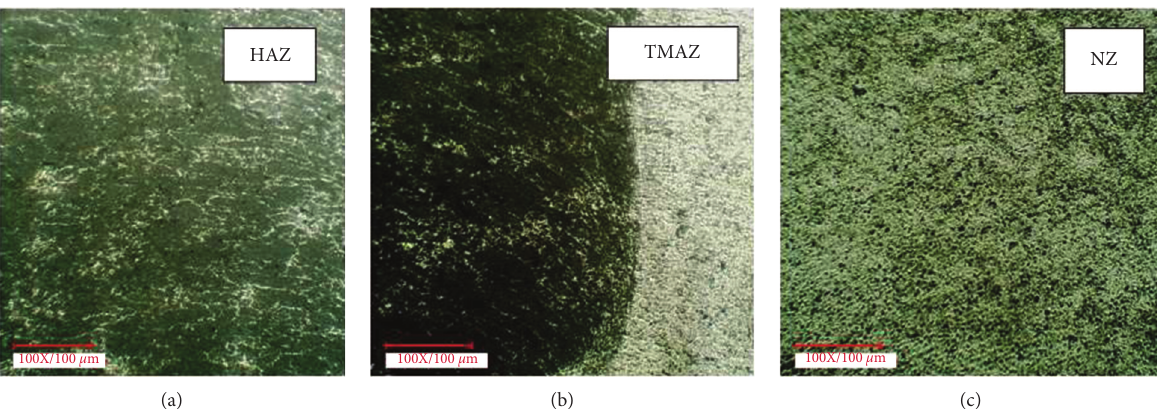
Figure 11: (a–c) Microstructure of cross section of bead-on-plate processed specimen at a tool spinning speed of 1200rpm, traverse speed of 30mm/min, and axial load of